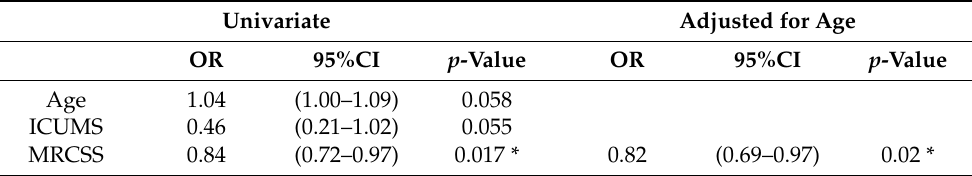
Table 5. The odds ratio of a hospital stay > 19 days based on age, ICUMS, and MRCSS.